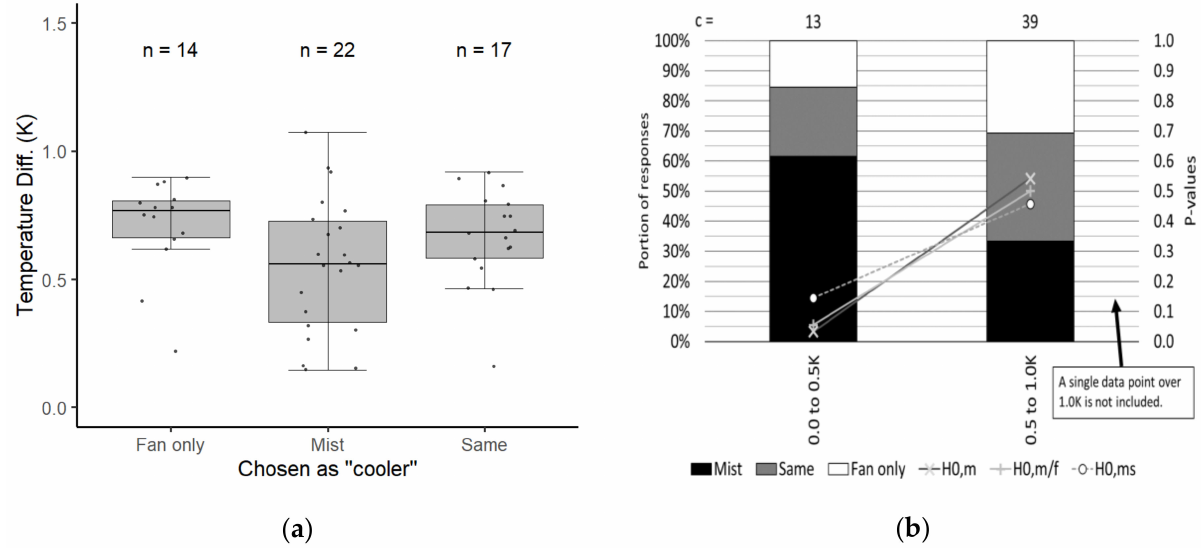
Figure 6. Distribution of temperature differences ( a ) and responses ( b ) from the third experiment trial. The fractions of responses for VMAS (“Mist”), FAS (“Fan only”) or “Same” for bins of 0.5 K in temperature difference are shown as stacked bar graphs in Figures 2b, 3b and 4b. The three null hypotheses are tested in each bin as compared to a cumulative binomial